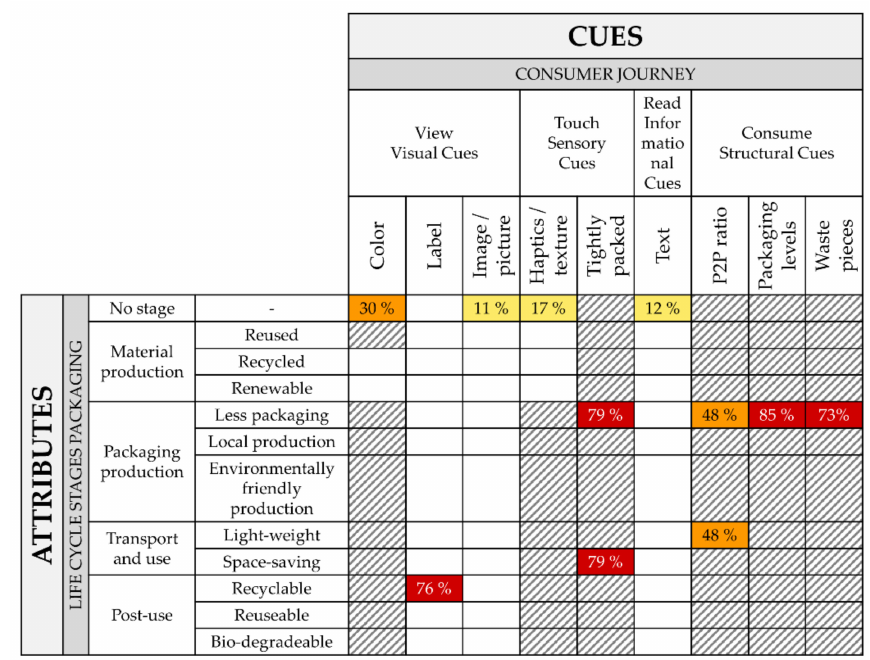
Figure 2. Heatmap of environmentally friendly cues that were utilized. Abbreviation: P2P ratio (product-to-packaging